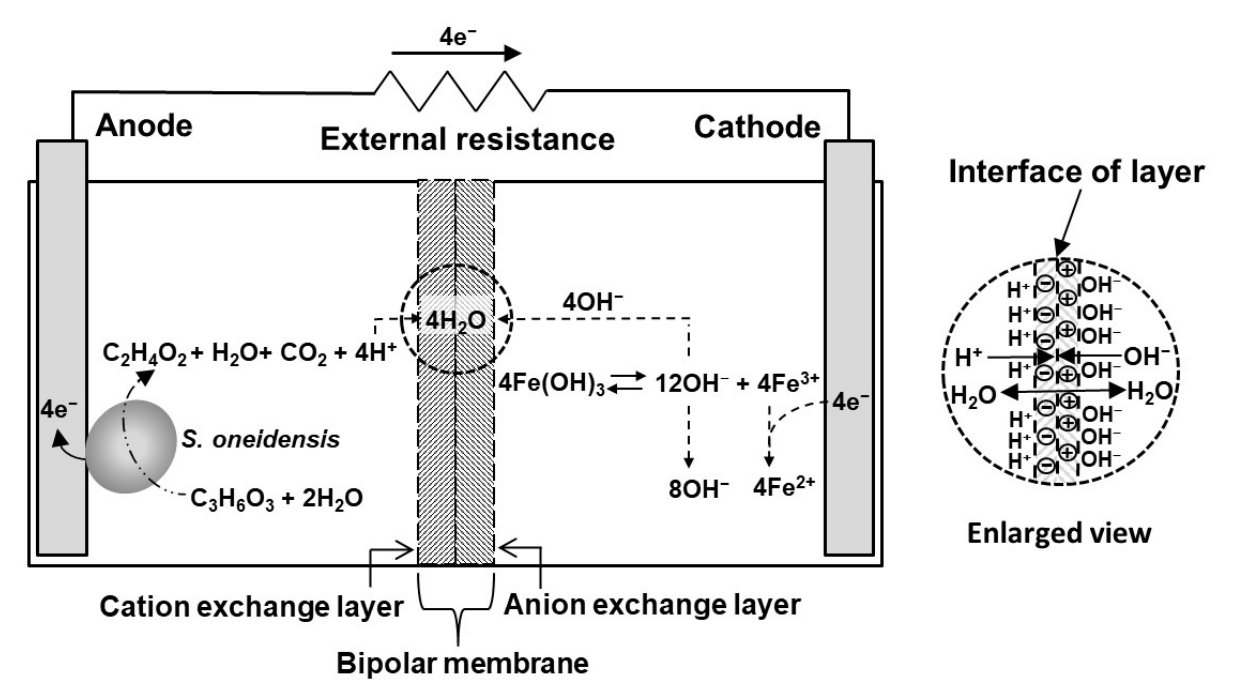
Figure 4. Reaction mechanism of bMFC-equipped bipolar membrane with Fe(OH) 3 . In the anode chamber, the lactic acid is metabolized to H + and electrons by S. oneidensis . The electrons are moved to the cathode chamber. The H + drawn to the bipolar membrane’s cation exchange layer. In the cathode chamber, Fe(OH) 3 is dissociated to OH − and Fe 3+ , and then, Fe 3+ is reduced to Fe 2+ by an electron. The OH − is drawn to the bipolar membrane’s anion exchange layer. Additionally, the H + is drawn to the bipolar membrane’s cation exchange layer. Then, H + and OH − react to form water on the interface of the anion and cation layers.